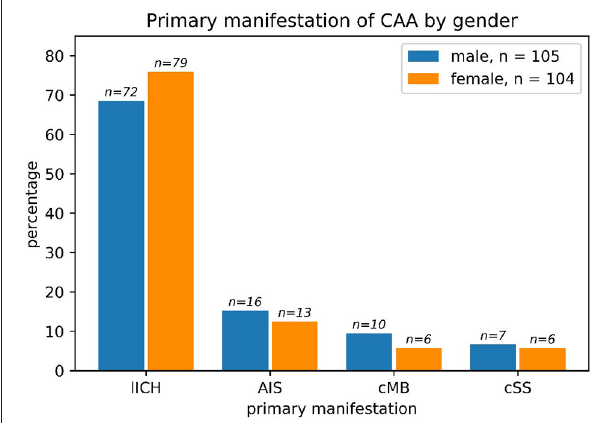
FIGURE 2 | The primary manifestation of cerebral amyloid angiopathy (CAA) in men vs. women such as lobar ICH (LICH), acute ischemic stroke (AIS), cerebral microbleeding (CMB), or cortical superficial hemosiderosis (cSS): Primary manifestation of CAA split by sex. The most common primary manifestation was ICB in both male and female patients. No significant differences could be found between the two sexes regarding primary manifestation (chi-square: p > 0.63). One male patient had both ICB and SAB/cSS and was counted to the ICB subgroup. The absolute numbers of patients are given above the bars. Percentages refer to the subgroup (all male patients, n = 105 and all female patients, n =